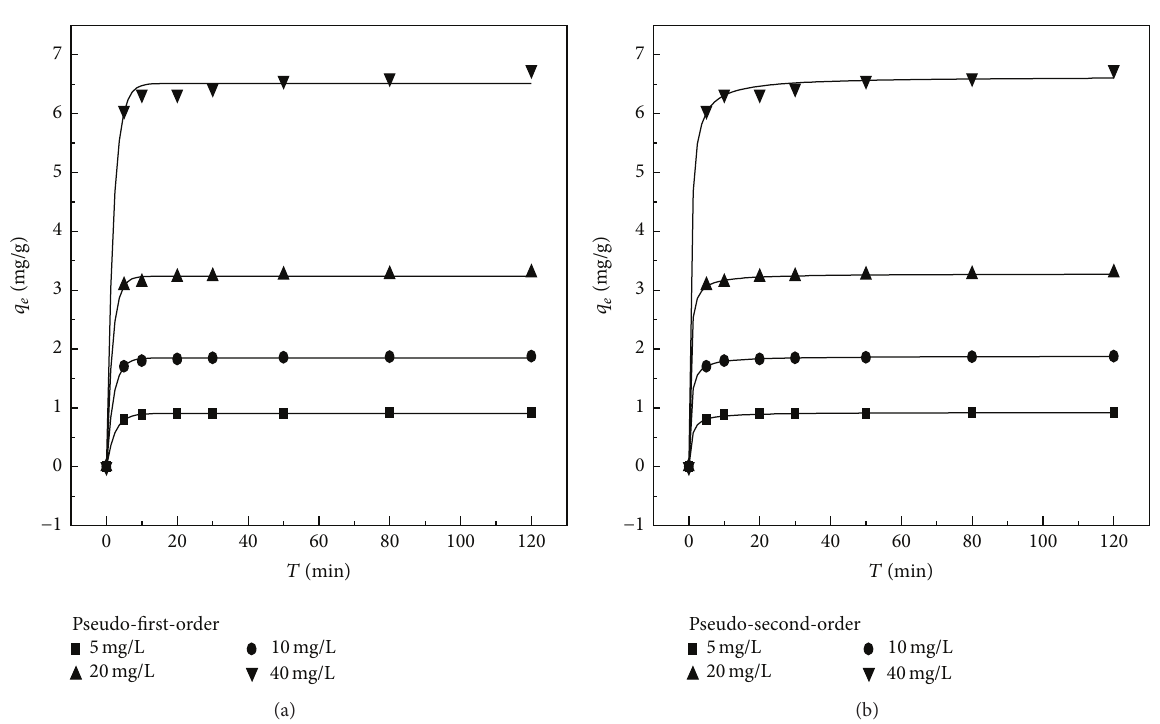
Figure 7: Pseudo-first-order and pseudo-second-order adsorption kinetics simulation curve of Cu(II) on AWS (conditions: adsorbent dose = 5 g/L, pH = 5, temp. = 25 ± 1 ∘ C, and stirring rate = 150rpm).